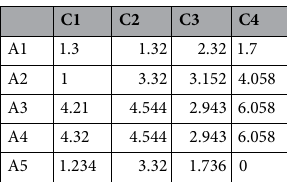
Table 9. The False-membership IC.